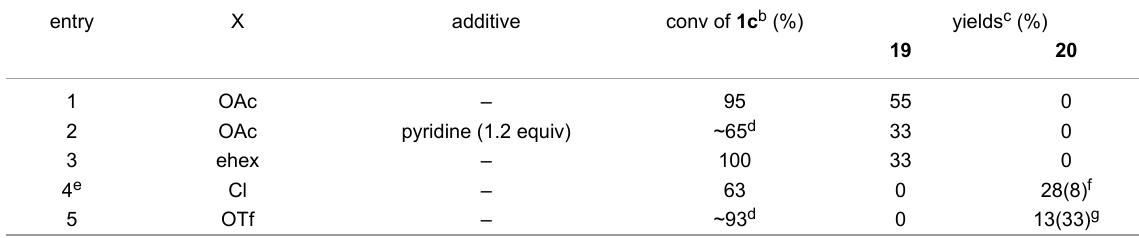
Table 3: Reaction of cyclopropanol 1c with various copper(II) salts (CuX 2 ).